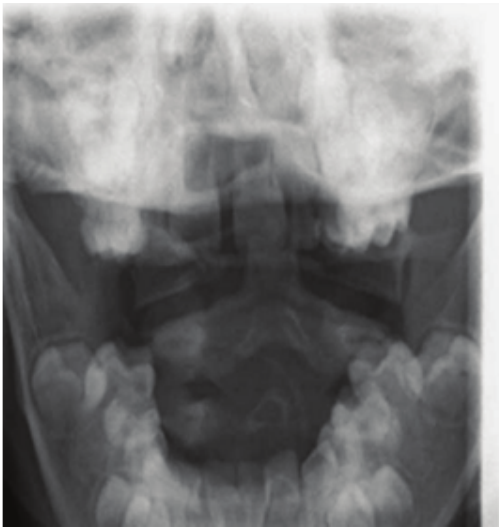
Figure 1: Open-mouth X-ray of the odontoid peg suggesting transverse fracture with lateral displacement through the odontoid peg.